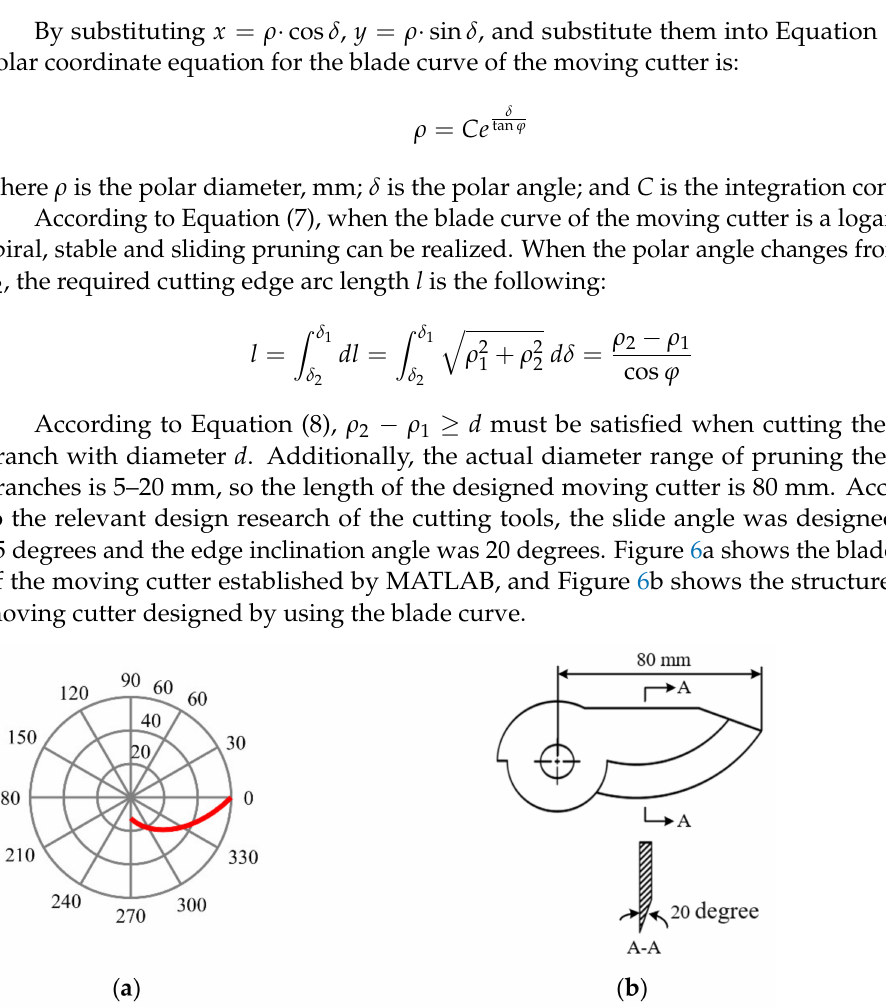
Figure 6. The model of the moving cutter. ( a ) The blade curve of the moving cutter, and ( b ) the structure of the moving